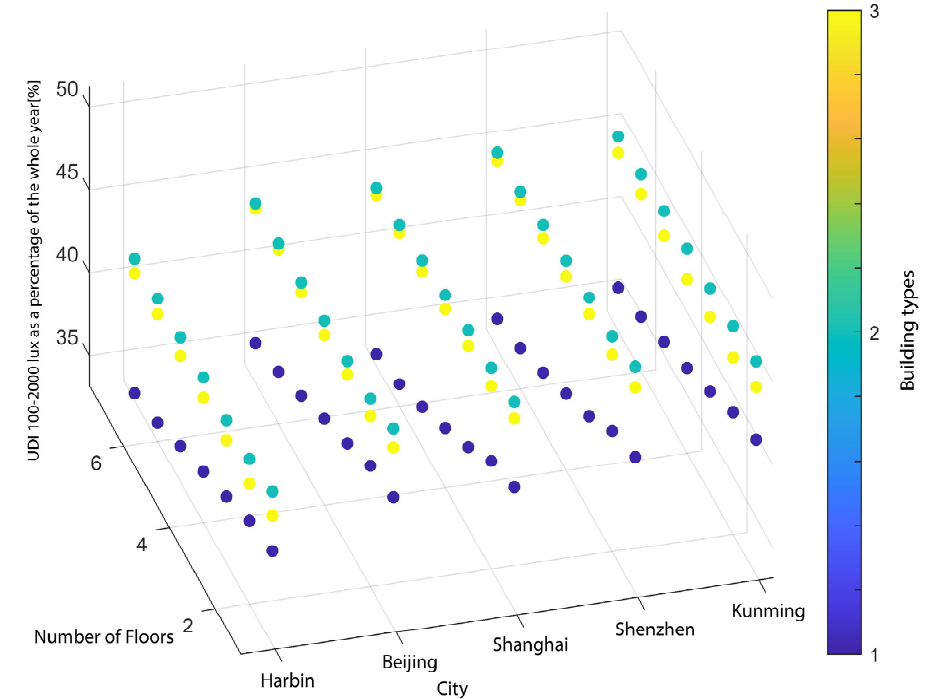
Figure 27. Relationship between the number of floors and the effective lighting illuminance of the whole